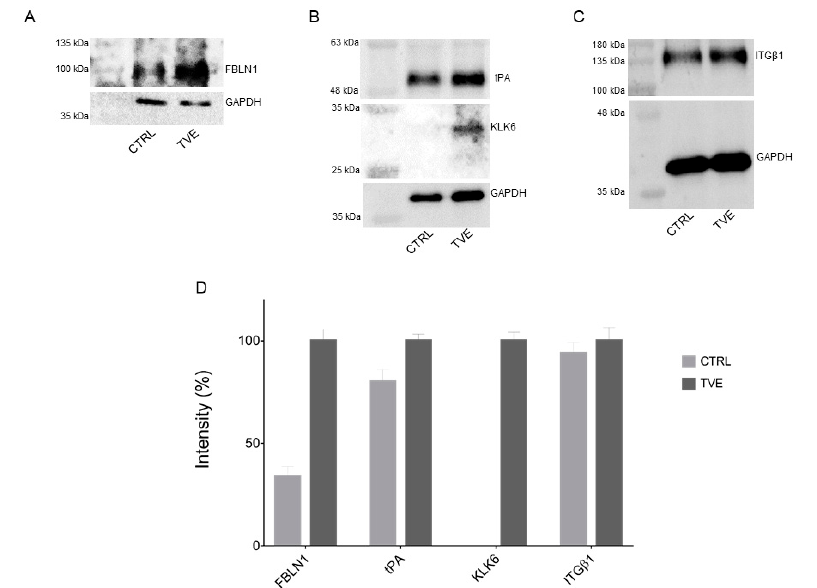
Figure 5. Mass spectrometry data validation through Western blotting for FBLN1 ( A ), tPA and KLK6 ( B ), and ITG β 1 ( C ), each reported with their respective GAPDH for loading normalization purposes. ( D ) Densitometric analyses of panel A, B, and C Western blots. GAPDH was used as a loading normalizer, and TVE intensities were set as